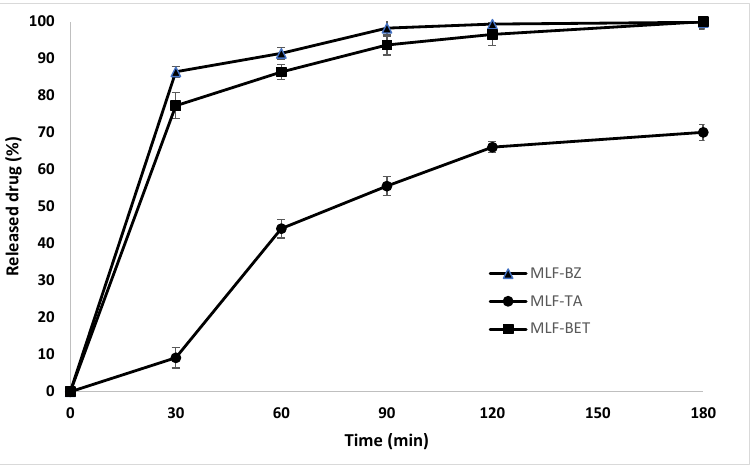
Figure 7. Release profiles of benzydamine hydrochloride (MLF-BZ), tolfenamic acid (MLF-TA) and betahistine dihydrochloride (MLF-BET), n = 3.